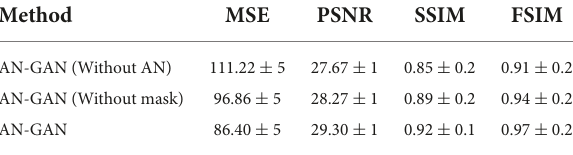
TABLE 1 Quantitative assessment of MRI image